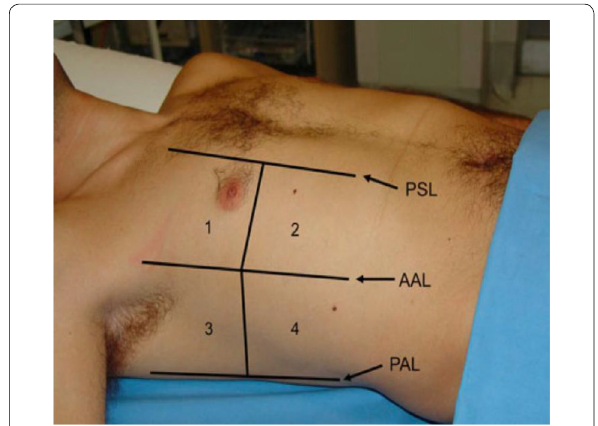
Fig. 1 The areas of lung ultrasonography considered in the study. Areas 1 and 2: upper anterior and lower anterior; areas 3 and 4: upper lateral and basal lateral. Each area was the same on right and left side. AAL, anterior axillary line; PAL, posterior axillary line [11]